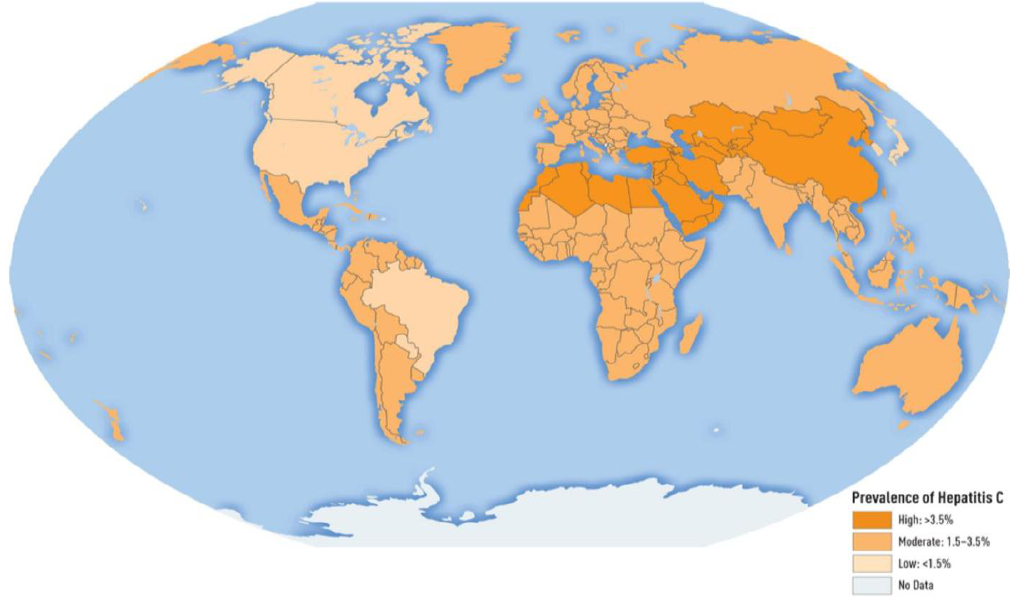
Figure 4. Global prevalence of hepatitis C virus [65]. This image was used with permission of the publisher.